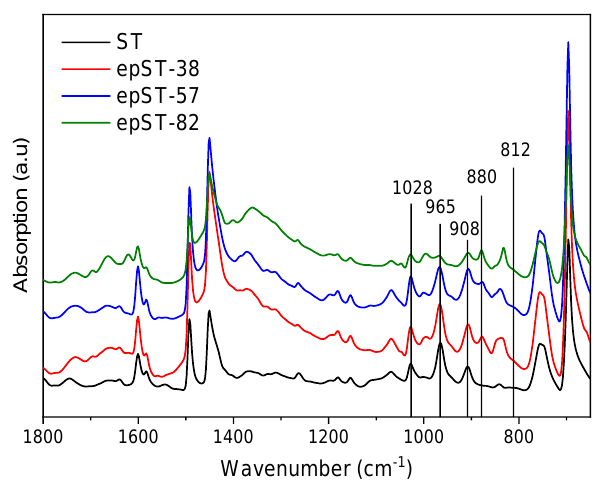
Figure 2. FTIR spectra of virgin Styrolux 3G55 (ST) and its epoxidized versions